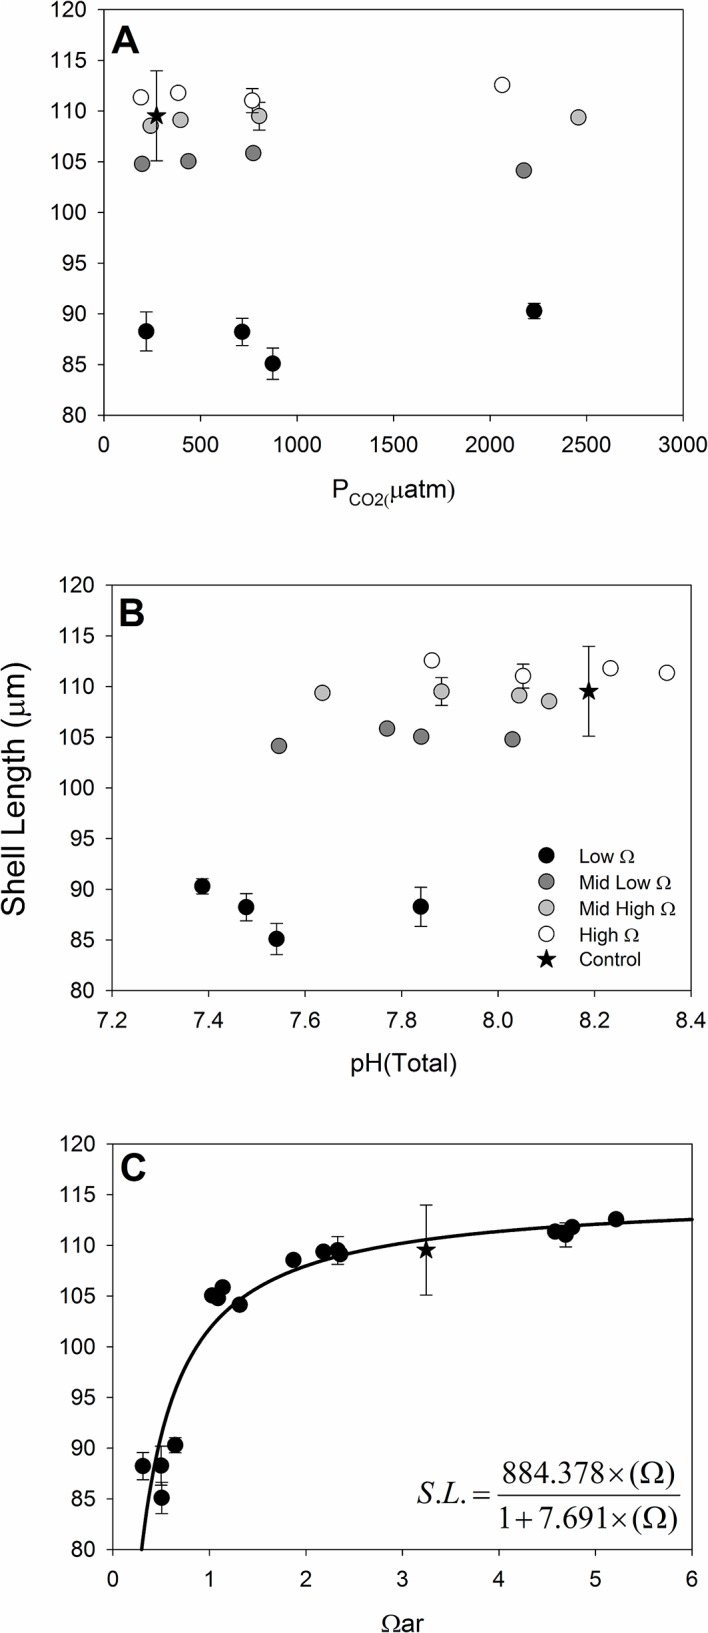
Normal Shell Length.Shell length of normally developed larvae (48 hours post fertilization and exposure) in relation to (A) PCO2, (B) pH, and (C) Ωaragonite. Greyscale symbols denote Ωar treatments in panels A and B, and the star indicates control data. Error bars are standard deviations of the three replicate BOD bottles per treatment. See text for fit of model noted on panel C.